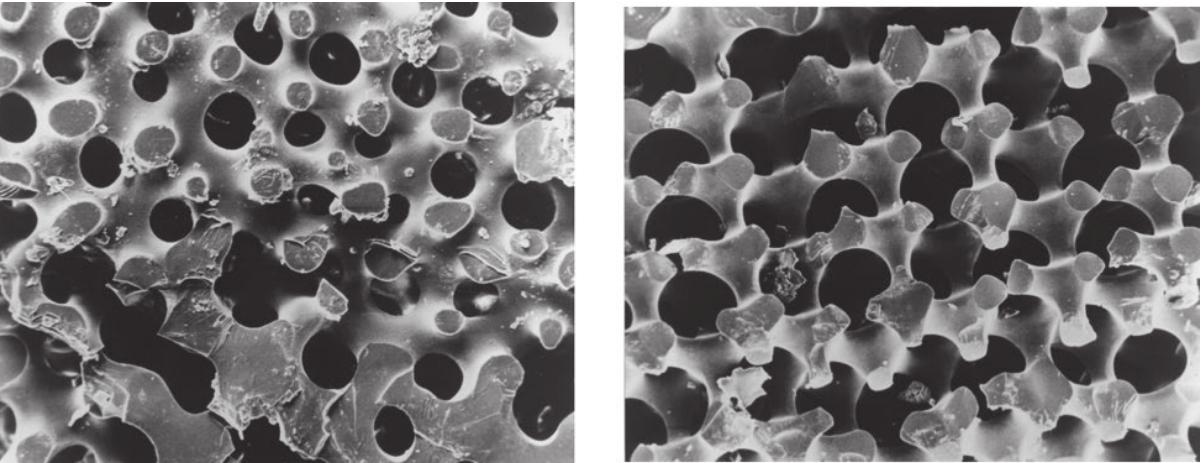
Figure 32. Scanning EM images of a skeletal plate of the sea-urchin Cidaris rugosa, aft er chemical treatment of the plate to remove pro- teinaceous tissue which lines the open channels in the living creature. Th e channels are microns wide (images courtesy Hans-Udde